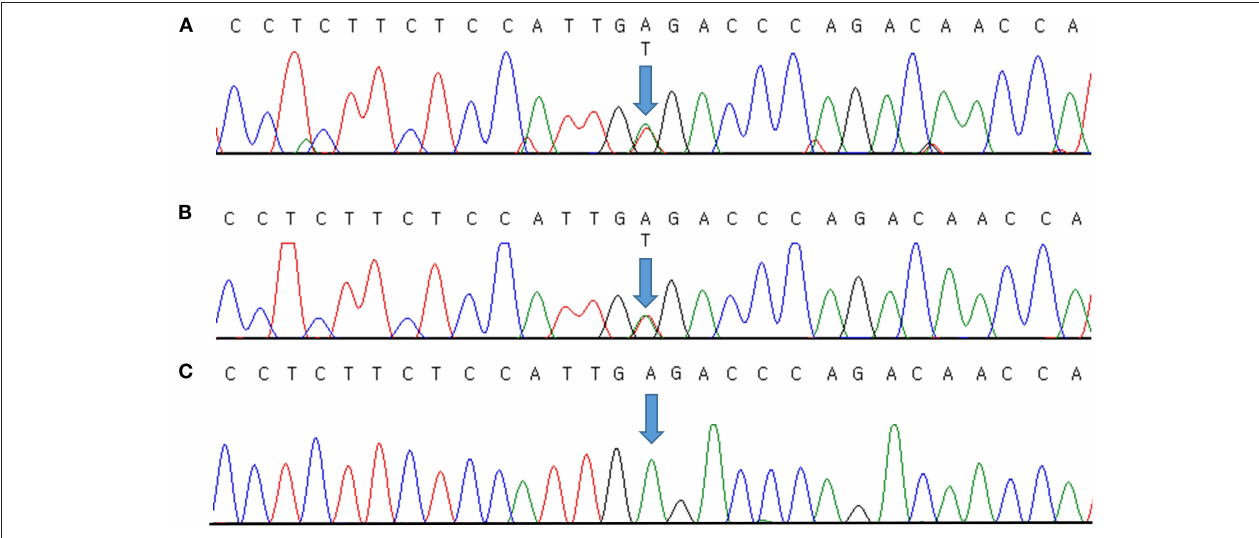
FIGURE 1 | Molecular characterization of a family with Andersen–Tawil syndrome. Sequence chromatogram showing the position of the c.413A > T transversion (NM_000891.2) that led to the p.(Glu138Val) missense variant. The variant was heterozygous in the proband (A) and her father (B) . Sanger sequencing result of an unaffected control (C) . Variants are annotated according to The Human Genome Variation Society